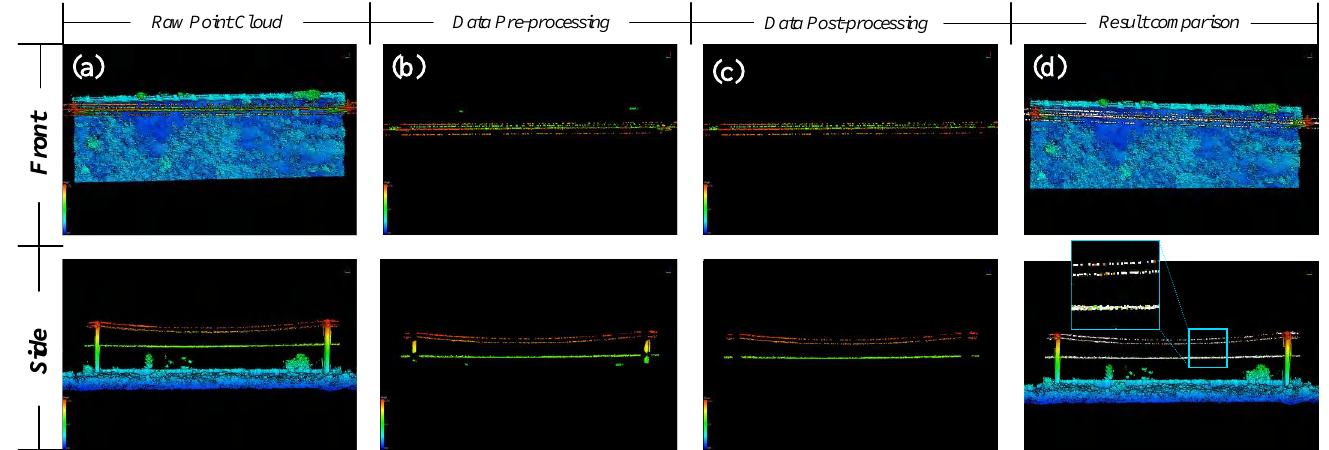
Figure 5. The front and side of the second set of sample point clouds (order from left to right): ( a ) before segmentation and extraction; ( b ) after preprocessing; ( c ) following segmentation and extraction; ( d ) displaying the results of the comparison (marked as white and color).